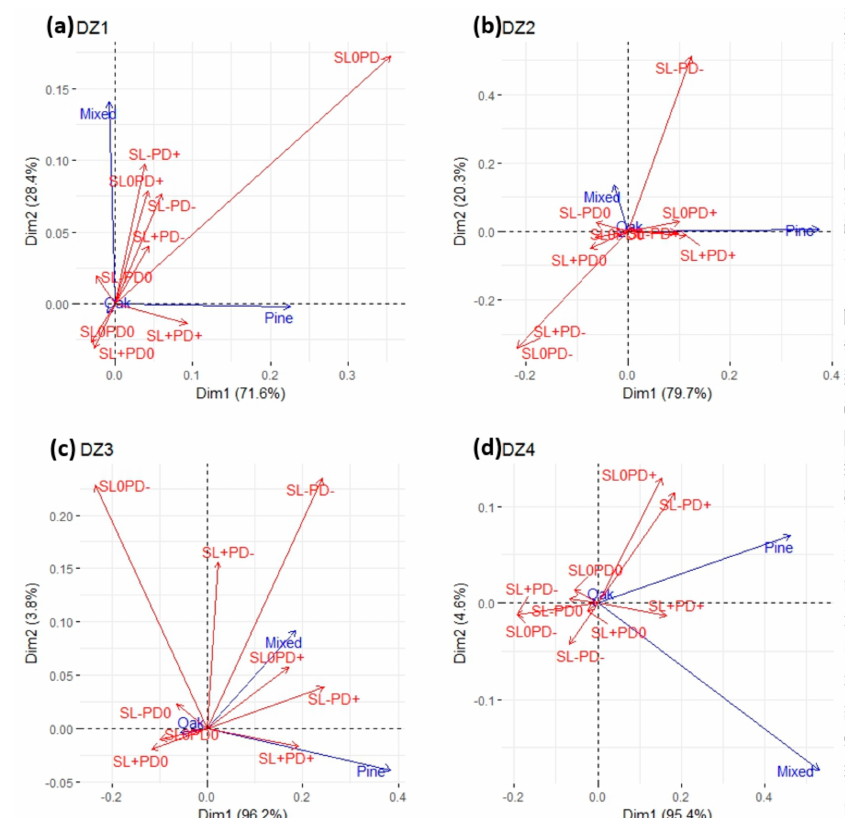
Figure 6. Correspondence Analysis (CA) results are present in bi-plots based on first two dimensions for four DZs ( a – d ). The dash lines are the first two dimensions. The two dimensions represented the two principle components among all variables. The percentage of the dimensions explained the variance in the data. The association was measured by the angle between the arrows for forest types and NDVIlin/SL combinations for each DZs. The acuter the angle is, the stronger the association is. SL and PD are the abbreviation for growing season length and productivity respectively. +, 0, and - sign indicate “increase”, “no change”, and